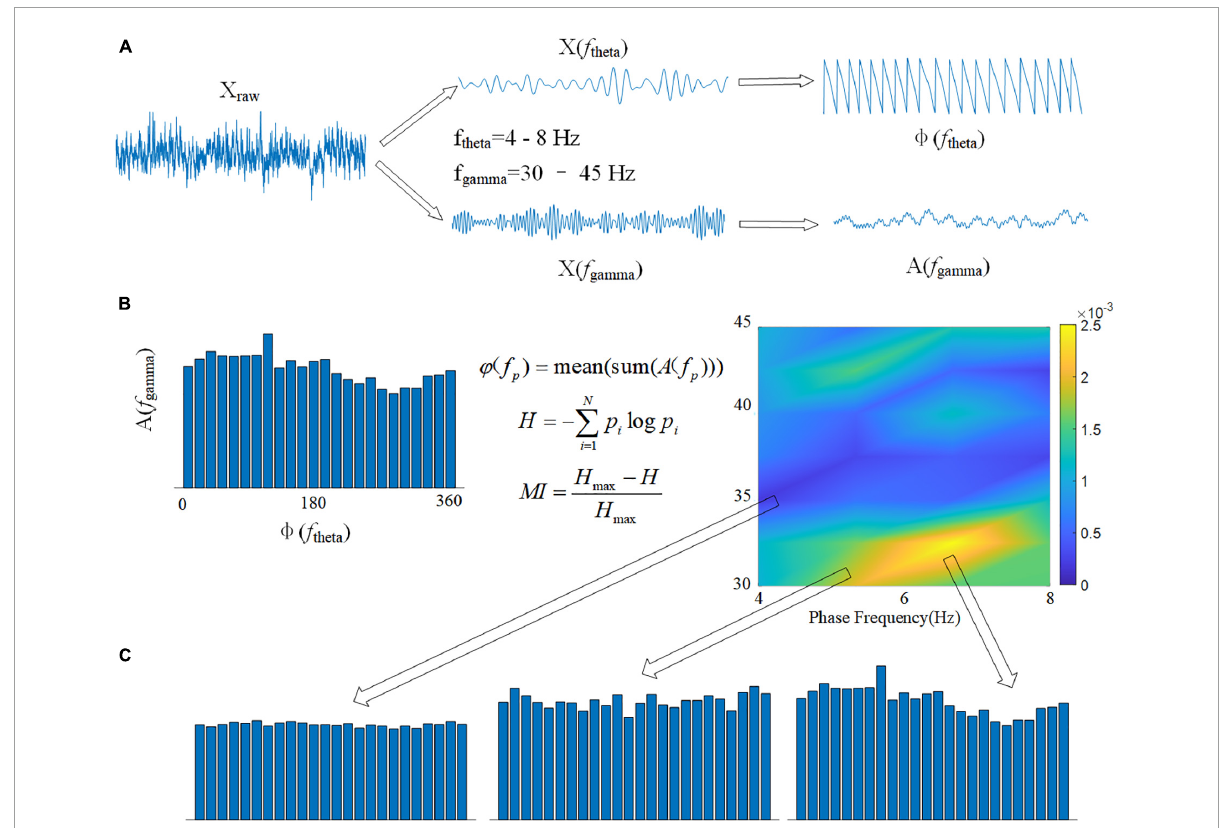
FIGURE3 Calculation flowchart for MI. (A) The original signal X raw is filtered in two frequency bands, and the phase of the theta band ϕ ( f theta ) and the amplitude of the gamma band A ( f gamma ) are calculated using the Hilbert transform. (B) Using the modulation index formula ϕ ( f p ) , calculate the average value of all amplitudes A ( f gamma ) corresponding to each 15 ◦ phase in boxes. The spectrum of MI can be drawn using 1 Hz as the phase frequency step and 2 Hz as the amplitude frequency step. (C) The variance of MI is represented by the depth of color in the